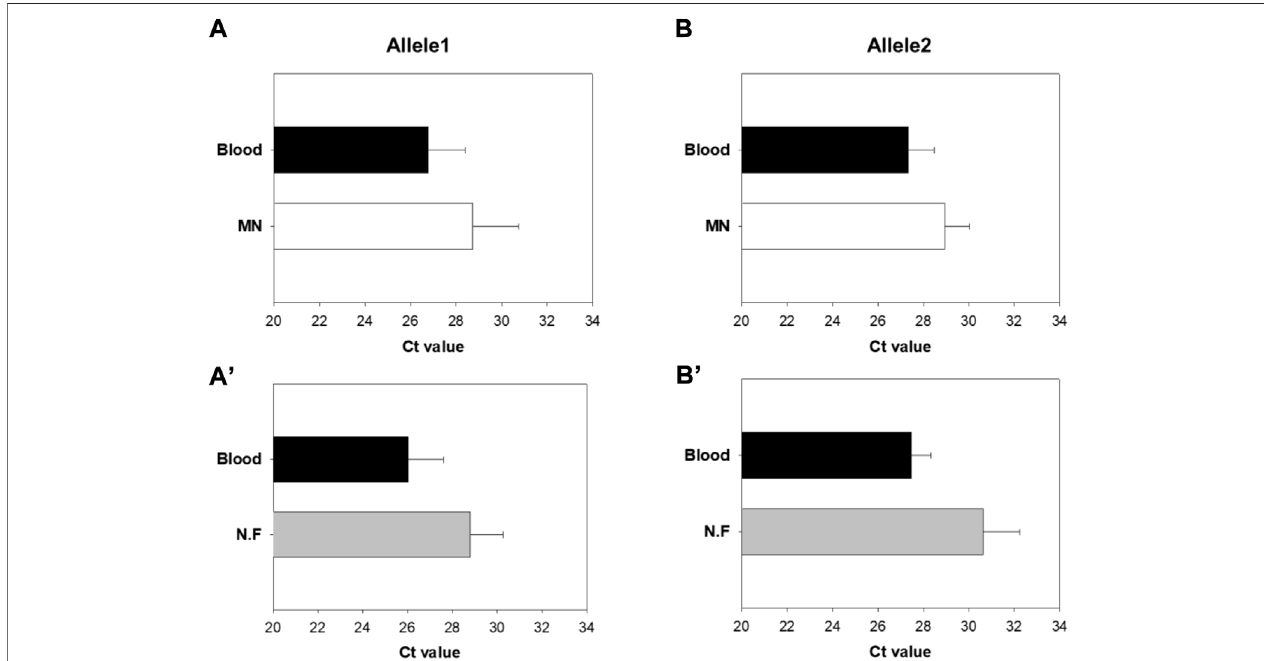
FIGURE15| Comparisonofcyclethreshold(Ct)valuesofGroupsAandBbyreal-timePCRoftheextractedDNA (A,A ʹ ) ResultsforAllele1 (B,B ʹ ) ResultsforAllele2 (MN: Microneedle swab, N.F: nylon fl ocked swab) (n = 5).